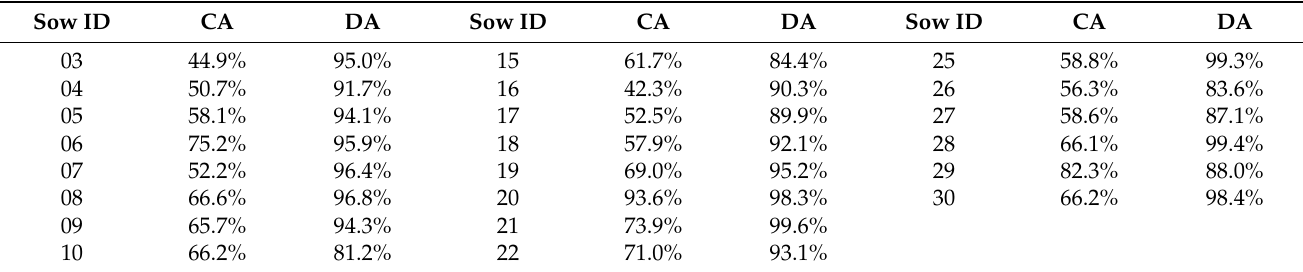
Table 4. Results of the number of piglets detected per